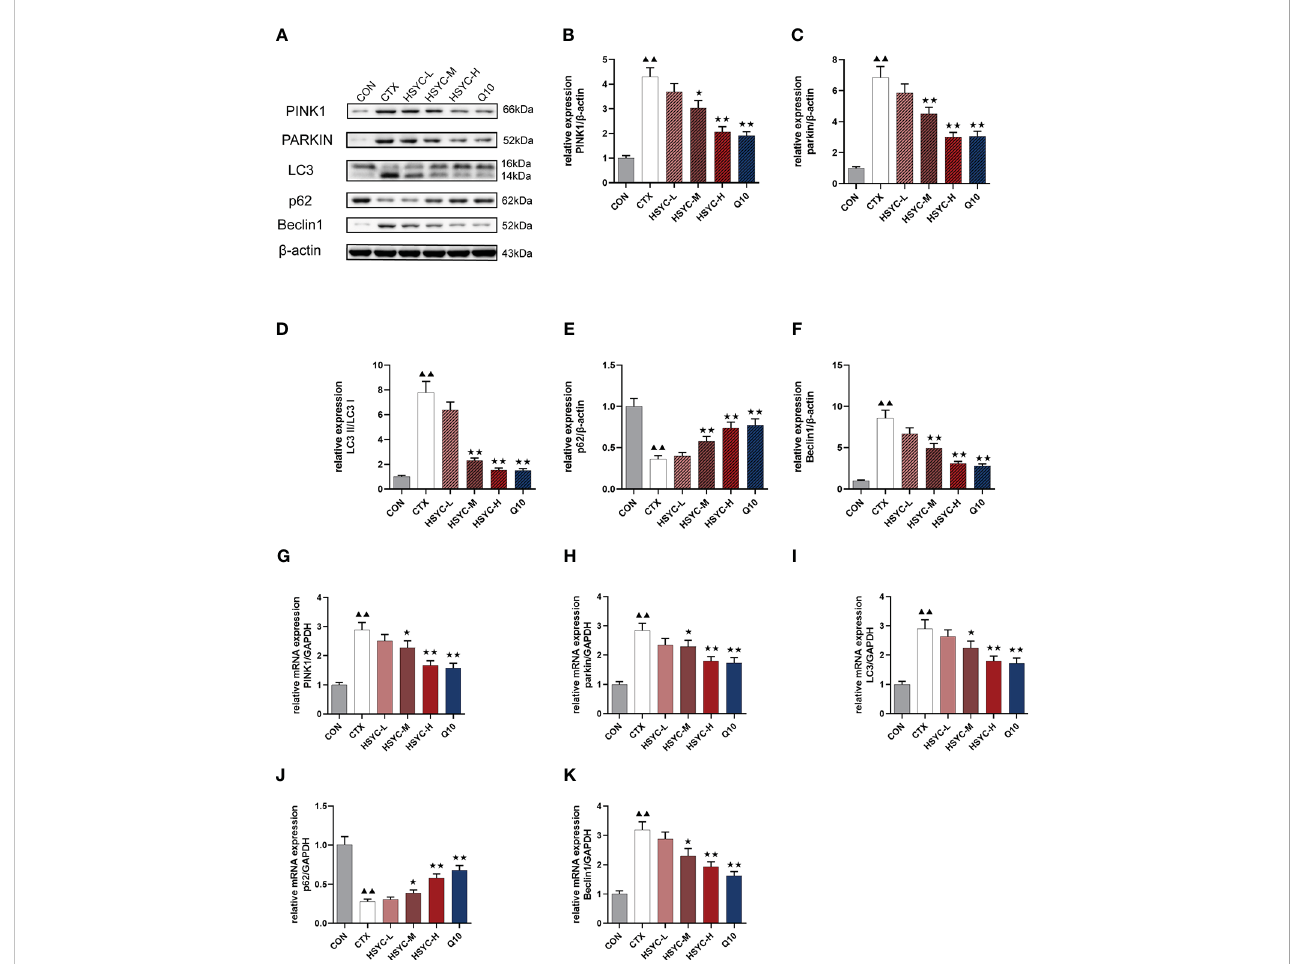
FIGURE 6 Effect of HSYC on the expression of mitophagy-associated genes and proteins. (A-F) Effect on PINK1, Parkin, LC3, Beclin1 and p62 proteins in the granulosa cells of different groups. (G-K) Effect on PINK1, Parkin, LC3, Beclin1 and p62 mRNAs in the granulosa cells of different groups. Histogram elements represent the mean ± SD (n=3). ▲▲ presents P < 0.01 compared to the CON group; ★ presents P < 0.05 compared to the CTX group; ★★ presents P < 0.01 compared to the CTX